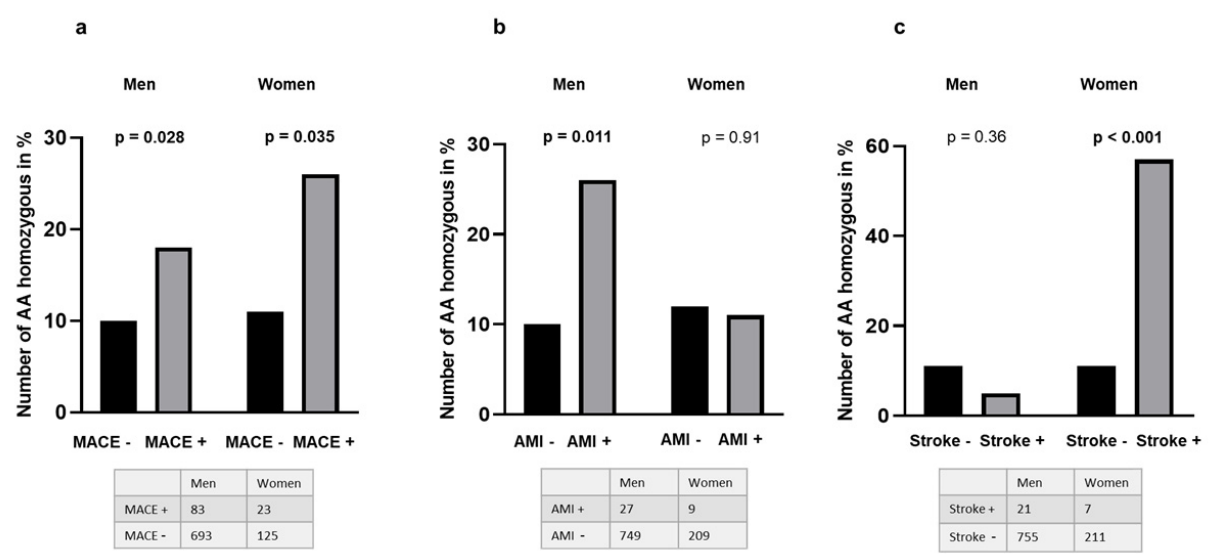
Figure 1. Association of the TERT rs7705526 mutation with MACE in certain subcategories. Tables underneath each figure denote actual numbers in different groups. ( a ) Frequency of TERT rs7705526 (C/A) homozygous subjects (AA) according to major clinical events (MACEs), separated by gender. Black and gray columns represent the % of AA homozygous without and with MACE, respectively. ( b ) Frequency of TERT rs7705526 (C/A) homozygous subjects (AA) according to acute myocardial infarction (AMI), separated by gender. Black columns represent the % of AA homozygous without AMI in both gender. The gray columns represent the % of AA homozygous suffering from AMI in men and women, respectively. ( c ) Frequency of TERT rs7705526 (C/A) homozygous subjects (AA) according to stroke, separated by gender. Black columns represent the % of AA homozygous patients without stroke. The gray columns represent the % of AA homozygous suffering from strokes in women and men, respectively.